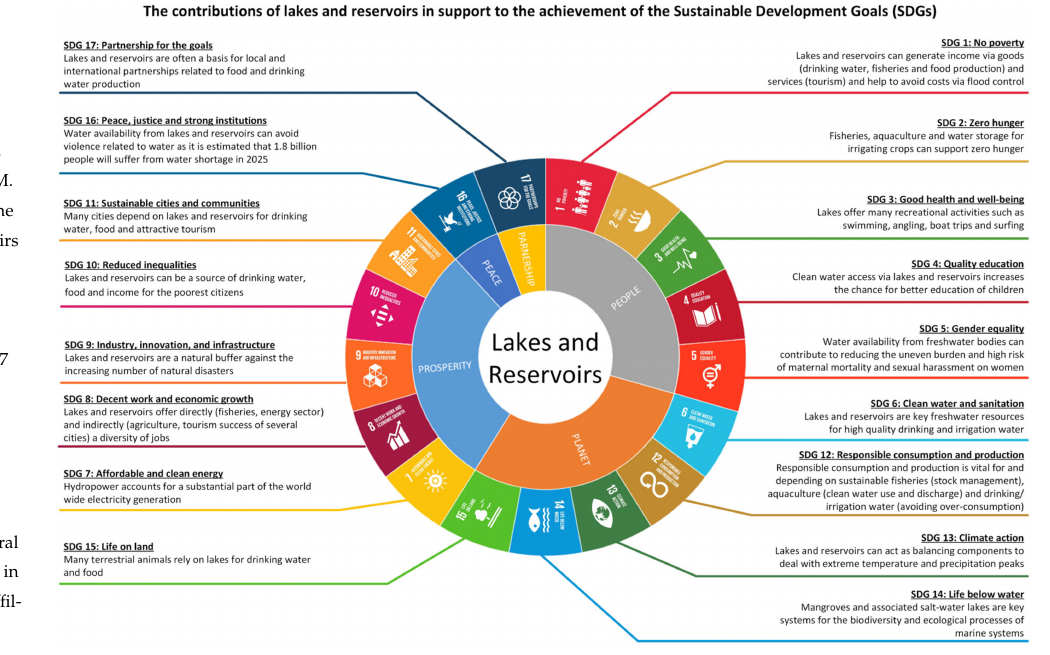
Figure 3. The summary of the contributions of lakes and reservoirs to support the achievement of the Sustainable Development Goals